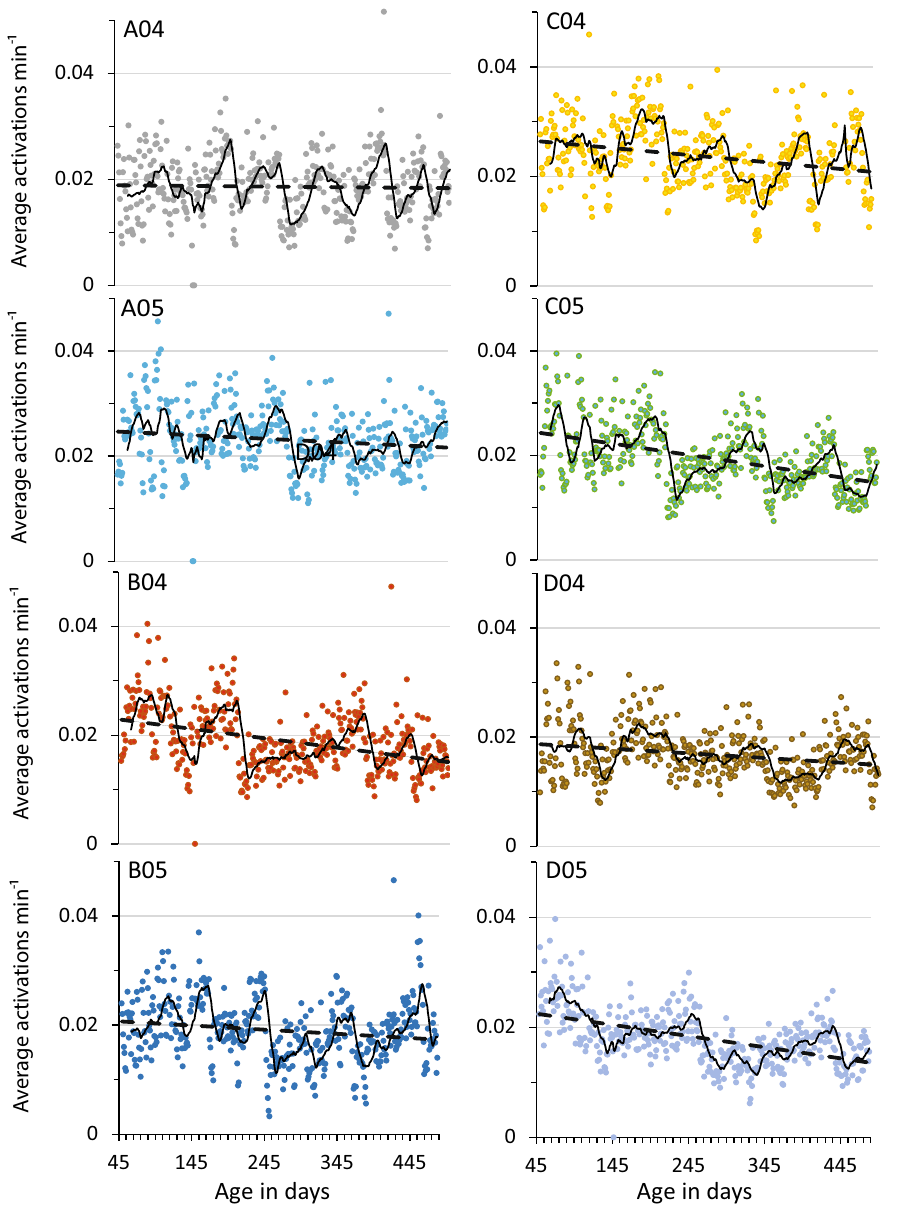
Figure 2. Plot of daily average activations min −1 for each of the cumulative data sets in Group 1; A04 depicted also in Fig. 1 is the top left panel. Cage ID is in each panel in the top left corner. The overall activity decreases with age as indicated by the interrupted black line (for linear regression details see Supportive information Table S1). The continuous black line of each panel represents the moving average using a window of one week (= cage-change cycle). As evident from the distribution of data points in each panel and the moving average trace, highs and lows are present in all cages but the dates for highs and lows are not synchronized across cages (for cage A04 the inverted triangles in Fig. 1c are the first five peaks). Ordinate is average daily activation min −1 . Abscissa at the bottom of each column is valid for all its panels and shows the age of the